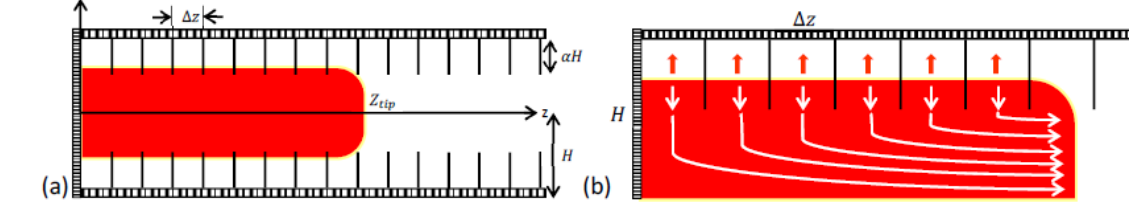
Figure 1. Illustration of flame acceleration inside an obstructed passage ( a ) and delayed burning between obstacles ( b ).